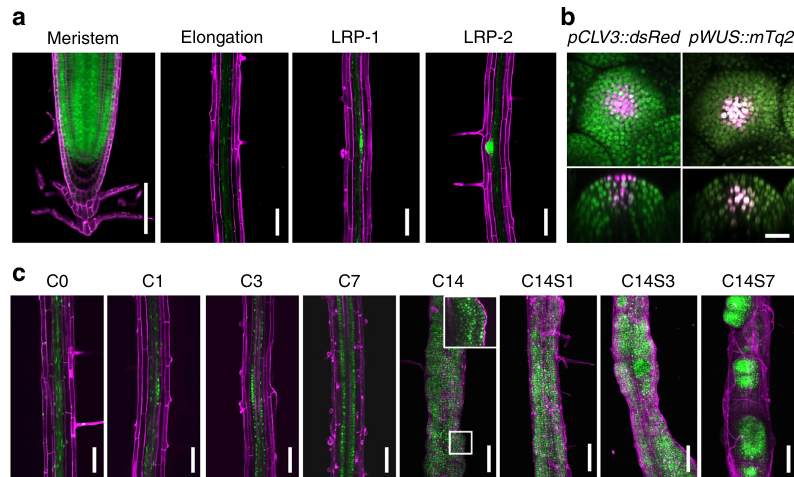
Fig. 2 LDL3 is expressed in the plant meristems and callus tissue. The expression pattern of the LDL3 translational reporter (green) in untreated roots. Meristem, a root apical meristem; Elongation, an elongation region; LRP-1, an early lateral root primordium; LRP-2, a late lateral primordium. ( a ), in SAM with expression of the SAM markers pCLV3::dsRed and pWUS::mTq2 (magenta) ( b ), and in root explants undergoing regeneration processes ( c ). All panels in ( a ), lower panels in ( b ), and the panels of C0 – 7 and the inset of C14 in ( c ) are single optical sections; all other panels are projections from confocal Z-stacks. The panels of C14 — C14S7 in ( c ) are combined images of two sequential projections. Cellular outlines were visualized with PI staining (magenta) ( a and c ). Scale bars: 100 µ m ( a and c ) and 20 µ m ( b ). See also Supplementary Fig.